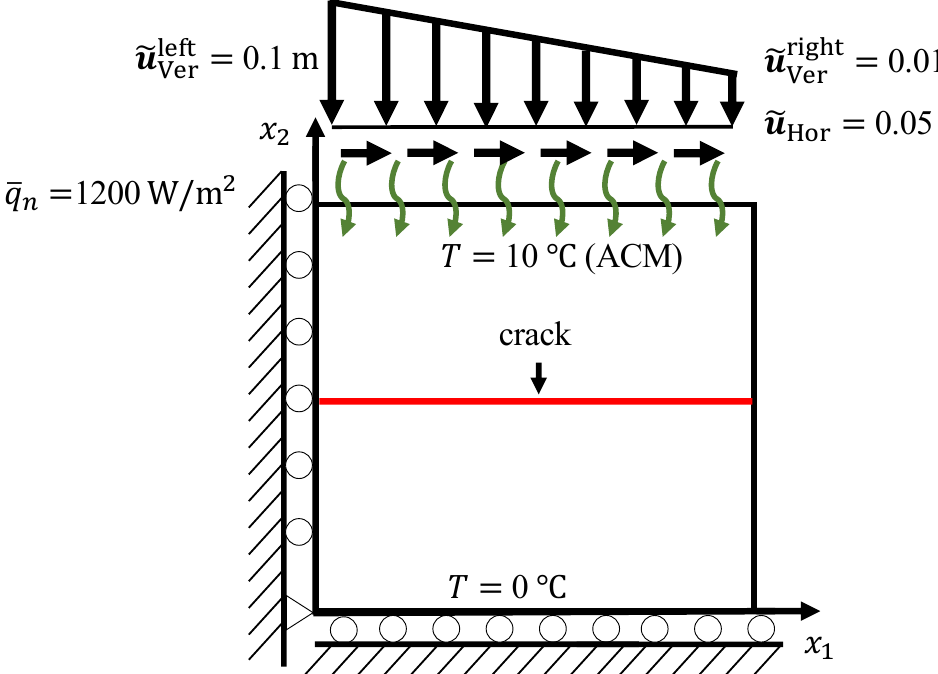
Figure 6. Thermo-mechanical modeling of a fractured body with frictional contact behavior Figure 10. Geometry illustration of the frictional sliding